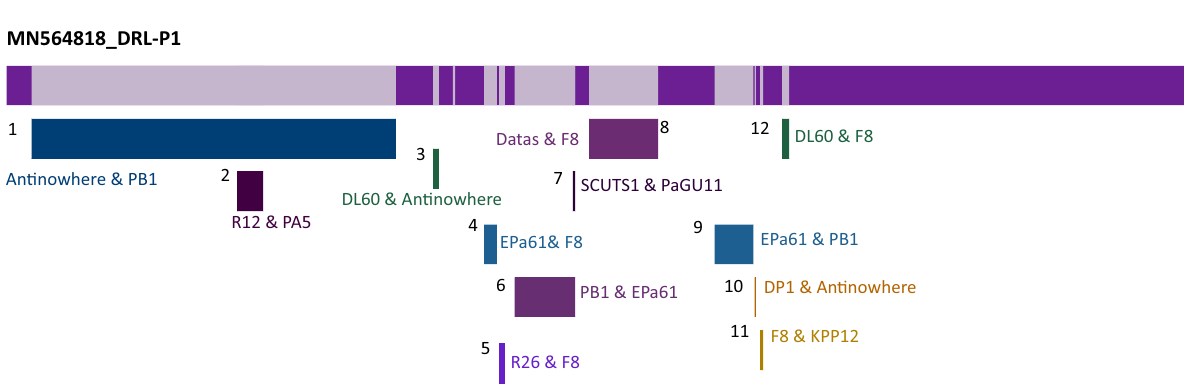
Figure 8. Neighbor-Net network tree was reconstructed with 100 GenBank sequences including 37 NCBI- RefSeq and DRL-P1complete genome sequence, using the SplitsTree4 computer program. Sequences were aligned using the CLUSTALW program. Kimura-2 parameter algorithm was employed for estimating genetic differences. The dataset included a total of 119,869 positions. Gaps and parsimony uninformative sites were excluded from analysis. Graphical presentation of the network tree was generated using SplitsTree4 computer program (version 4.14.6; https:// uni- tuebi ngen. de/ en/ fakul taeten/ mathe matis ch- natur wisse nscha ftlic he- fakul taet/ fachb ereic he/ infor matik/ lehrs tuehle/ algor ithms- in- bioin forma tics/ softw are/ split stree/).